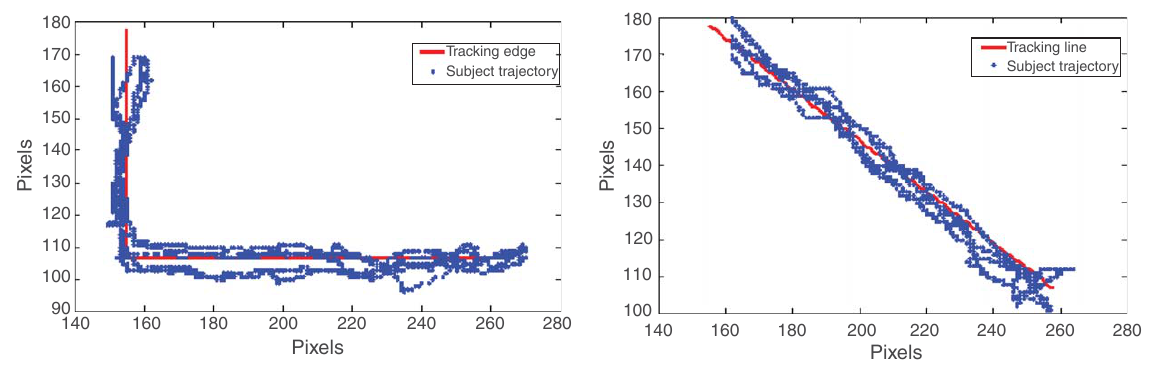
Fig. 8. Line and edge tracking performance of the impaired subject with assistive